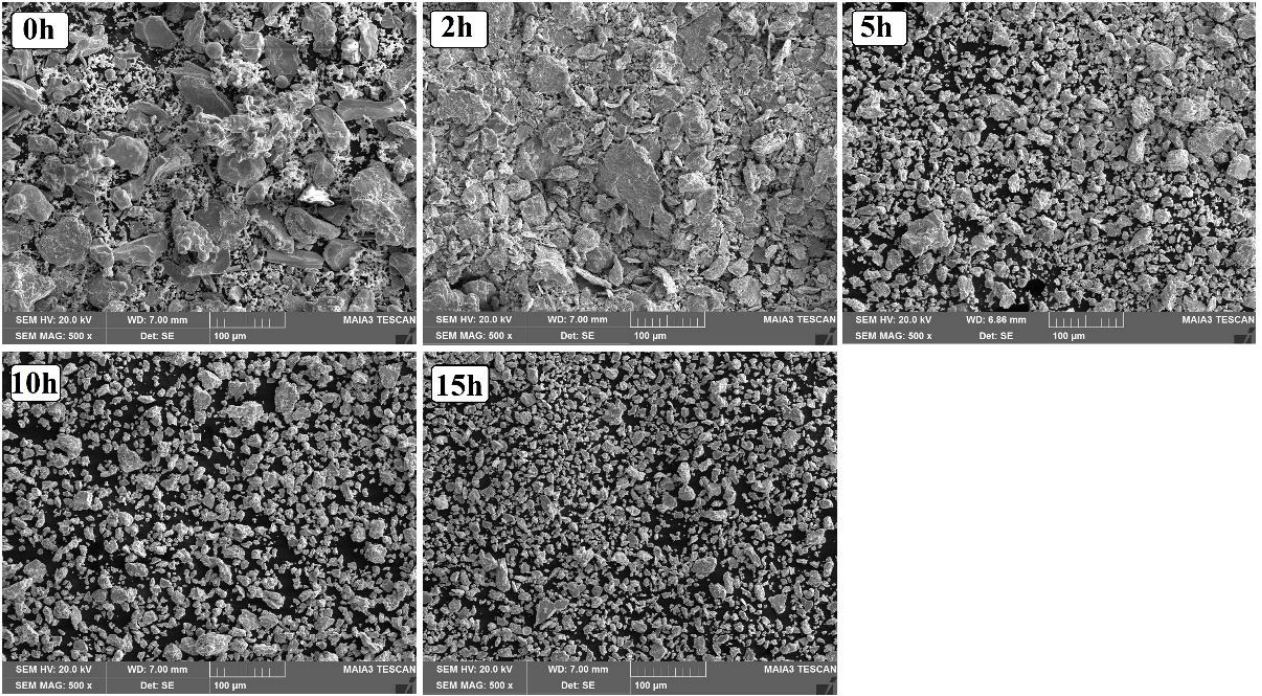
Figure 5. SEM of 0, 2, 5, 10, and 15 ball-milled 23Fe-21Cr-18Ni-20Ti-18Mn HEA powders.